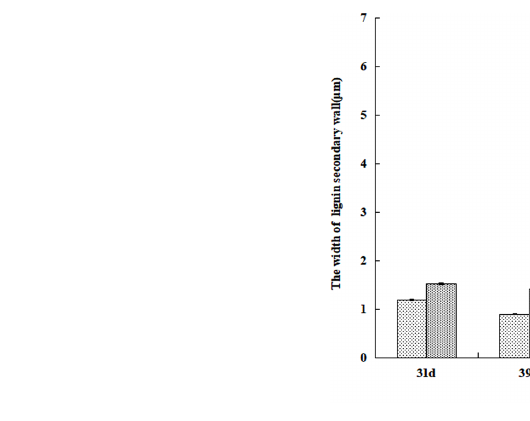
FIGURE 6 The width of Secondary wall layer of DY and